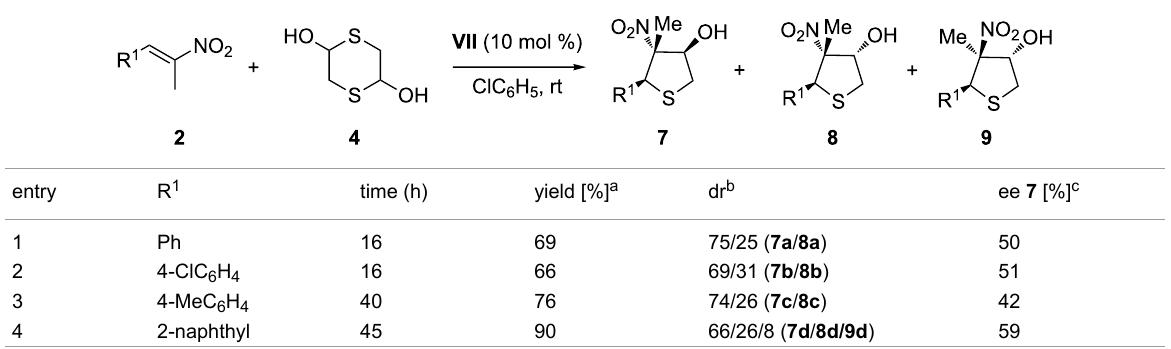
Table 3: Asymmetric sulfa-Michael/nitroaldol reaction of nitroalkenes 2 with 1,4-dithiane-2,5-diol ( 4 ) catalysed by amine thiourea VII .